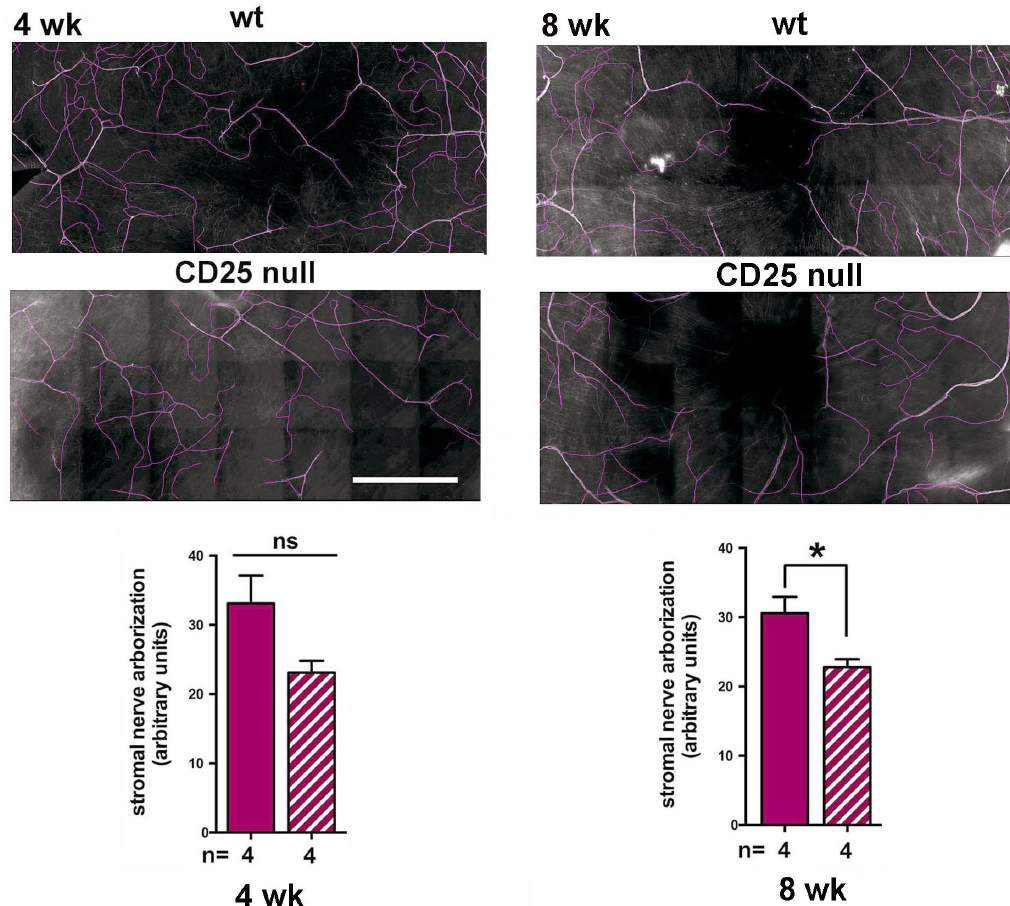
Figure 4. Stromal nerve arborization is reduced in CD25 null corneas. Whole flat mount corneas stained with β III tubulin were imaged below the level of the ICNs within the stroma; 4 corneas from 4 and 8 wk female mice were imaged for each variable assessed. Stromal nerve arborization was traced using NeuronJ. Shown are representative images obtained at 4 and 8 wk of age in wt and CD25 null corneas. In wt corneas at 4 wk, stromal nerve arborization is more variable between individual corneas than at 8 wk. Although stromal nerves are less abundant at 4 wk in CD25 null corneas (hatched bar), the difference is not significant. By 8 wk, the variability in the wt corneas is reduced and the difference in the null corneas is significant. Bar = 500 µ